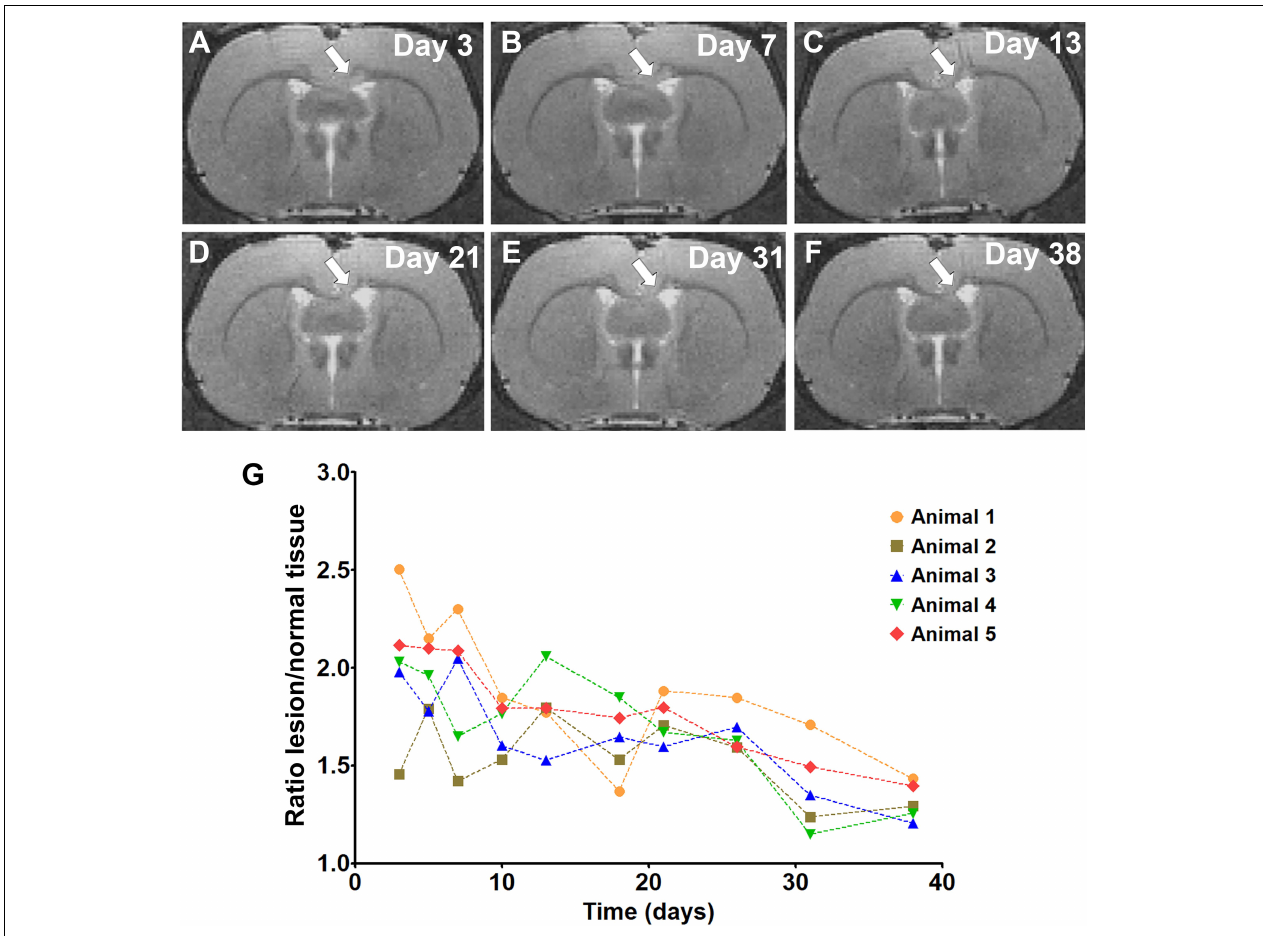
FIGURE 1 | T2 weighted images showing the lesion in the corpus callosum (white arrow) and its development from day 3 to day 38 (A–F) . The graph represents the signal intensity ratio between lesioned and normal tissue on individual days (G)